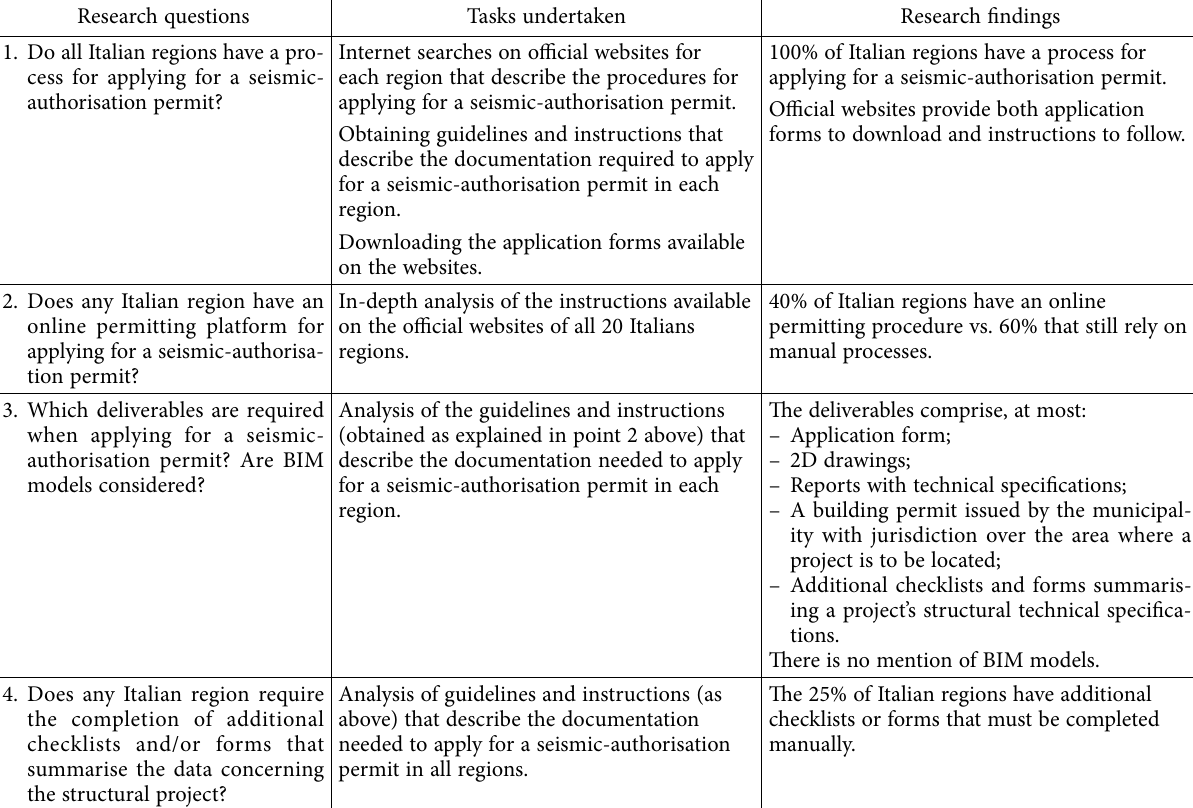
Table 2. Summary of the process of researching, organising and synthesising the